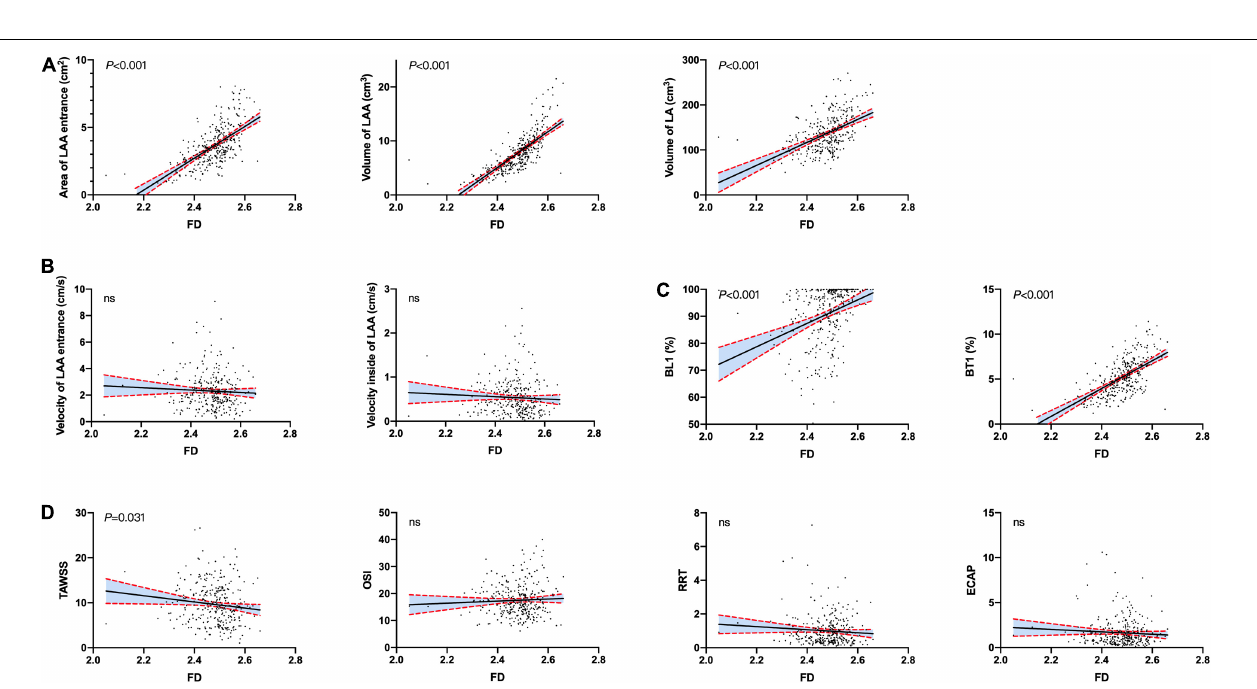
FIGURE 6 | Linear regression of FD and hemodynamic parameters. (A) The correlation between FD and LAA/LA morphological parameter. (B) The correlation between FD and blood flow velocity in LAA. (C) FD was positively related to the ratio of residual blood volume to LAA/LA volume at the end of the first cardiac cycle. (D) FD was markedly negatively related to TAWSS. BL1%: Ratio of the volume of blood remaining in the LAA to the volume of the LAA at the end of first cardiac cycle. BT1%: Ratio of the volume of blood remaining in the LAA to the volume of the entire left atrium at the end of the first cardiac cycle.